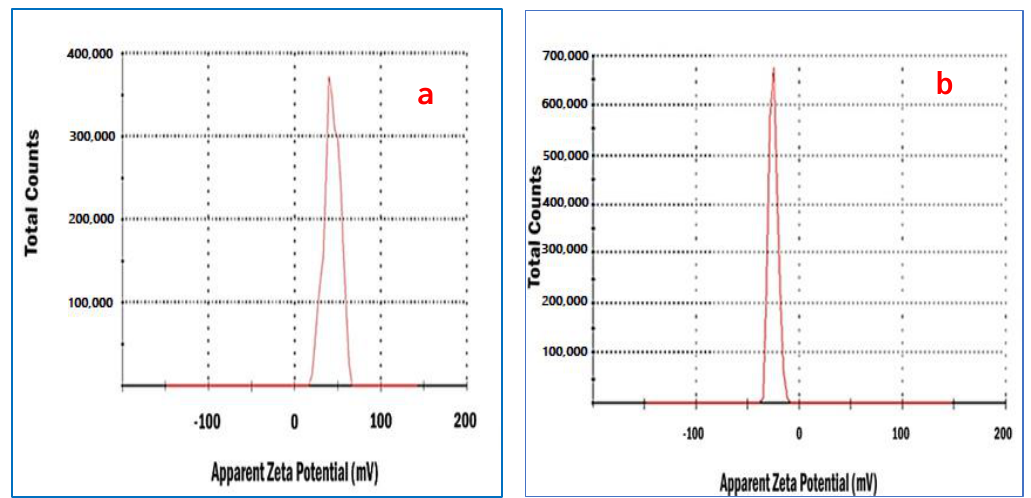
Figure 3. Zeta potential analysis of synthesized ( a ) Fe-AC; ( b ) ZnO − NPs samples.